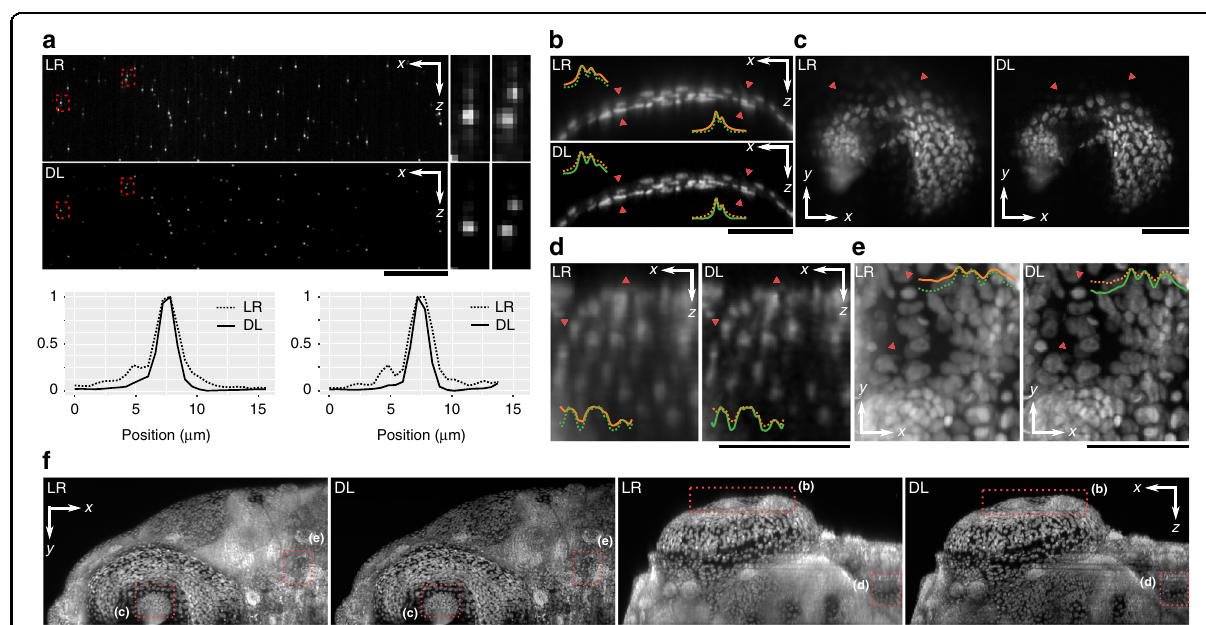
Fig. 7 Learned deconvolution in a multiphoton LSM with a Bessel beam. a Fluorescent beads encoded by a Bessel PSF (LR) deconvolved using deep learning (DL). Zoomed-in regions correspond to areas marked by the red rectangle. Line plots are representative of the axial intensity pro fi le, showing deconvolution of side lobes. b – f Zebra fi sh embryo sections: b cross-sections of the iris; c enface sections of the pupil; d cross-sections of the body; e enface maximum intensity projections (20 μ m) of the body. Line insets correspond to intensity pro fi les along the regions marked by red triangles. In ( c ), red triangles illustrate out-of-plane defocus. f Maximum intensity projections of the entire sample in the cross-section and enface planes. Red rectangles mark locations corresponding to ( b – e ). Scale bars are 50 μ m in ( a – e ) and 200 μ m in ( f